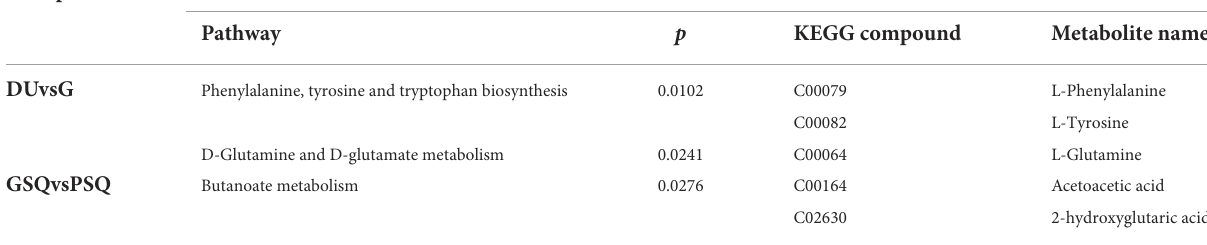
TABLE 3 Pathway enrichment results of the KEGG database. Group a KEGG Pathway p KEGG compound